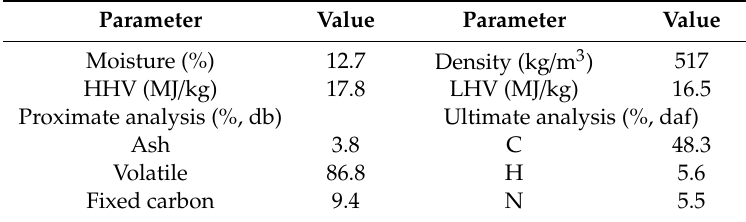
Table 1. Characterization of brewers’ spent grain pellets [13].